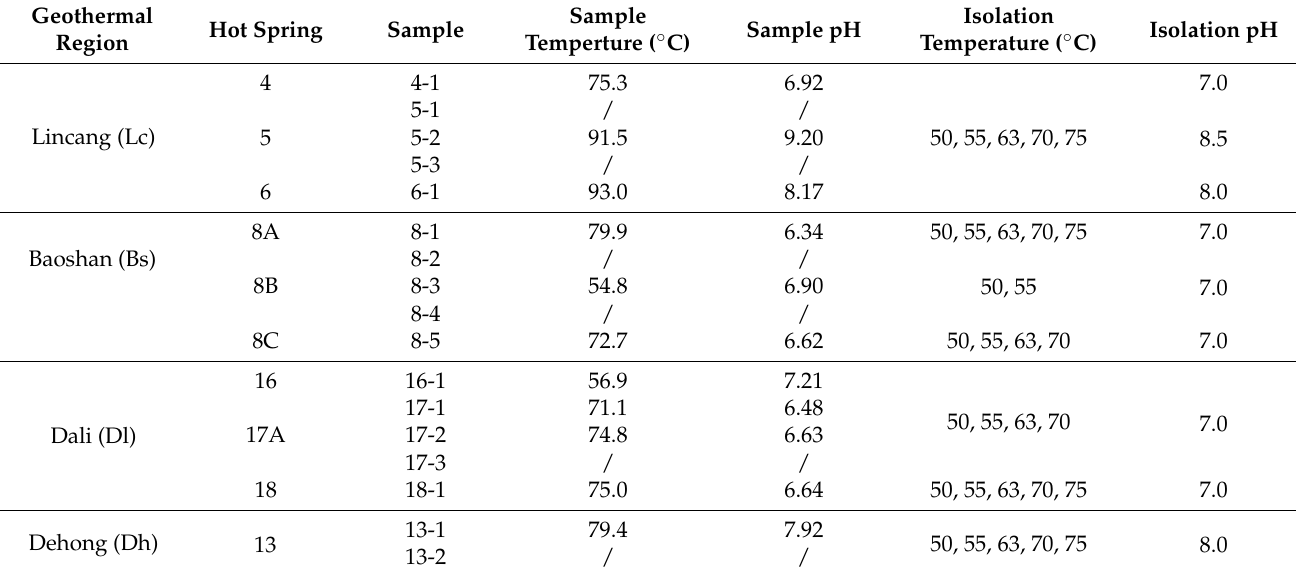
Table 1. The sample characteristics and isolation conditions of the four geothermal regions of southwestern Yunnan Province. /, Not data